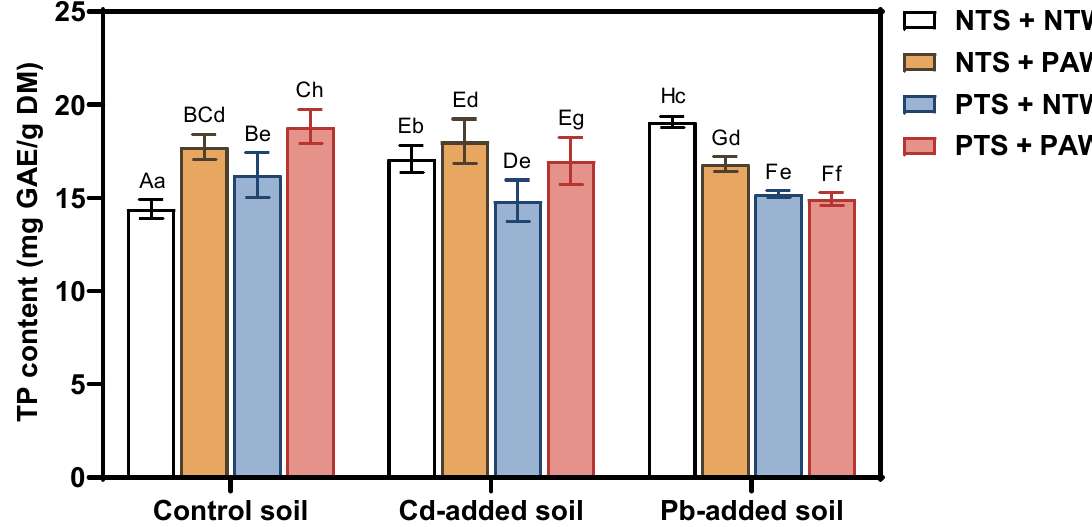
Figure 4. Comparison of TP content in water spinach with different plasma treatments grown in different soil. NTS: non-treated seed; NTW: non-treated water; PAW: plasma-activated water; PTS: PAW-treated seed. Different uppercase letters indicate the significant difference between plasma treatment, while different lowercase letters indicate the significant difference between cultivation soil.